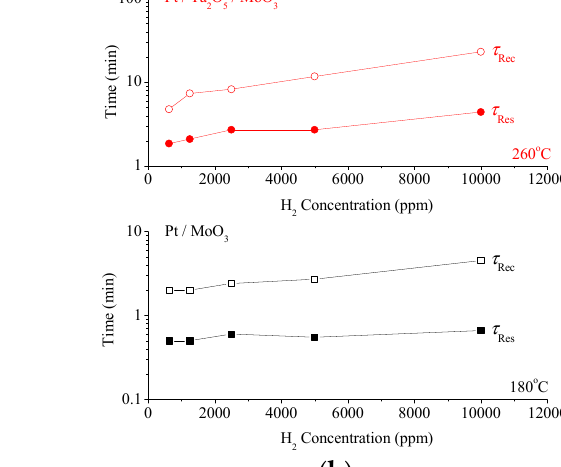
Figure 5. ( a ) Forward bias (+10 μ A) dynamic H 2 gas response of the ( a ) Pt/Ta 2 O 5 /MoO 3 heterojunction diode at 260 ° C, to concentrations of 625, 1250, 2500, 5000 and 10,000 ppm (upper figure). Response time τ Res and recovery time τ Rec of the heterojunction across H 2 concentrations (lower figure). ( b ) Reverse bias (–10 μ A) dynamic response towards H 2 gas of the Pt/MoO 3 Schottky contact at 180 ° C under the aforementioned concentrations (upper figure). τ Res and τ Rec of the Schottky contact across H 2 concentrations (lower figure).